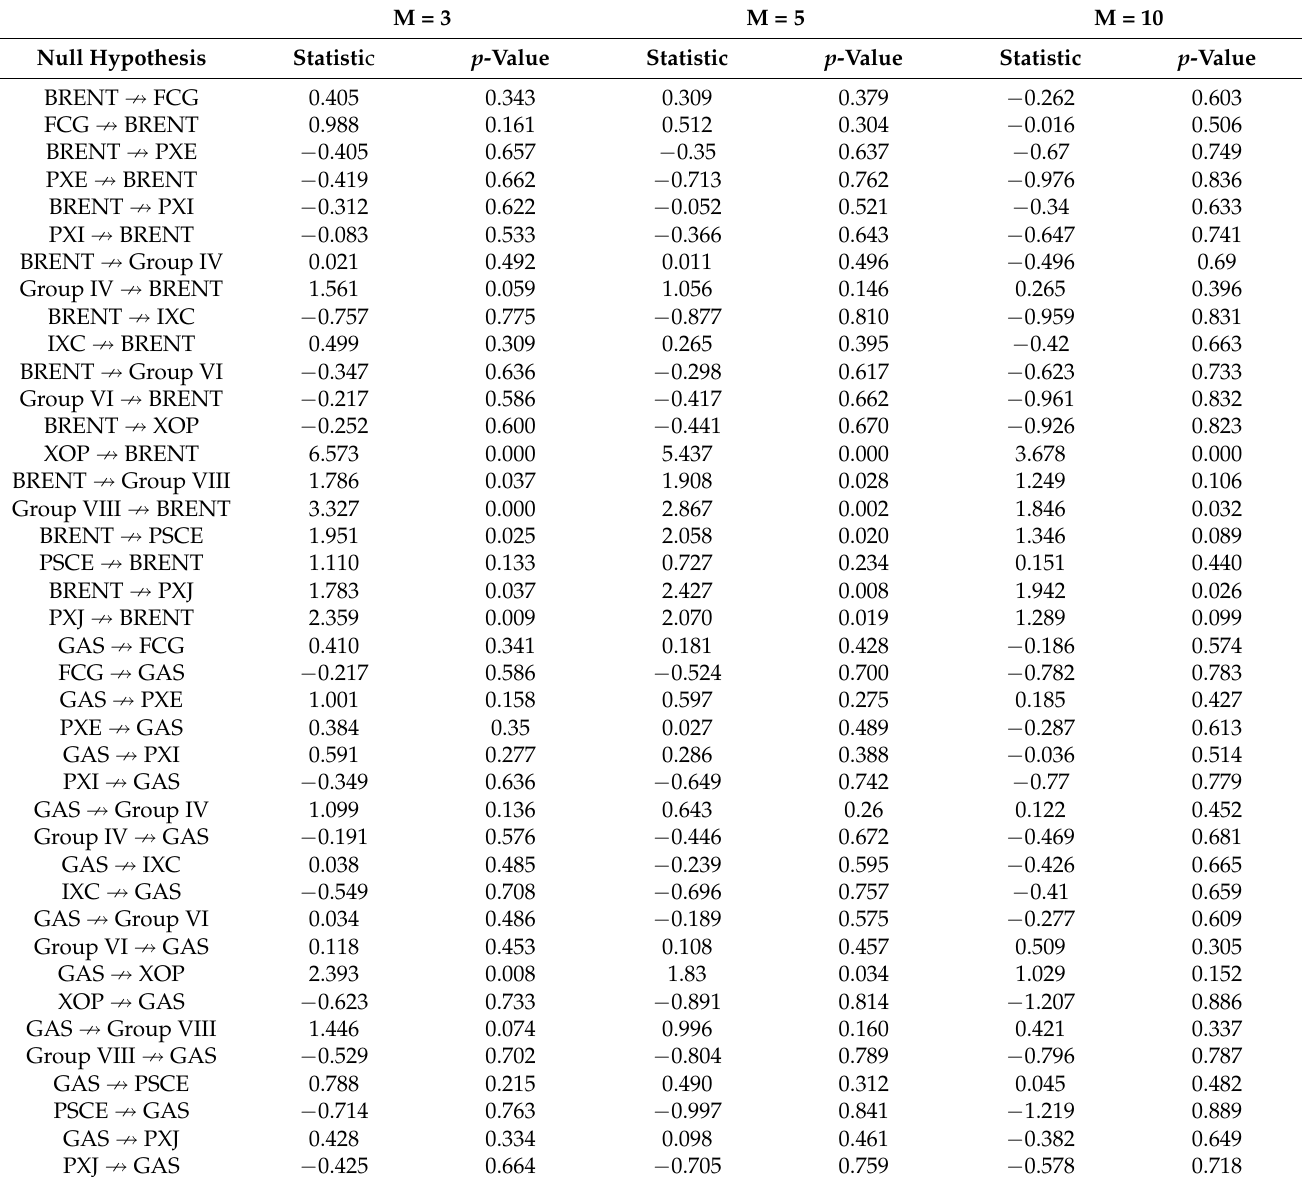
Table 2. Hong test